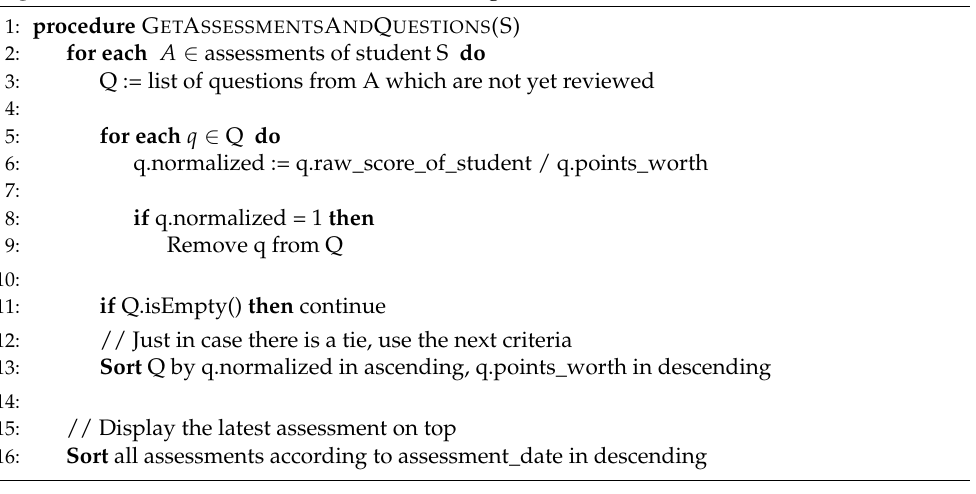
Algorithm 1 Assessment and Question Listing in the Reminders